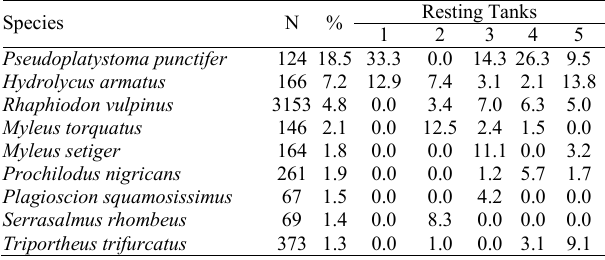
Table 3. Fish species with the greatest frequencies of injuries (bites) in the resting tanks along the Lajeado fish ladder (> 1% of individuals injured). The table shows the total number of individuals caught (N), the average percentage of injured fish along the ladder (%), and the percentage of injured fish in each resting tank (Resting Tanks in order from down to